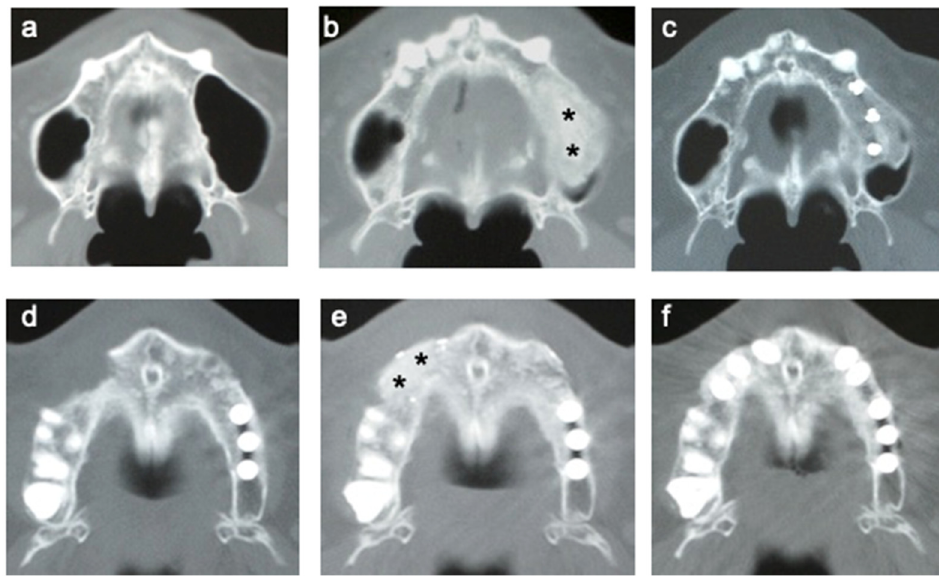
Figure 5 . CT images of regenerated alveolar bone: ( a – c ) maxillary sinus floor augmentation and ( d – f ) alveolar ridge augmentation. ( a , d ) Before surgery, ( b , e ) 6 months after transplantation (asterisks indicate regenerated bone), and ( c , f ) 12 months after transplantation.